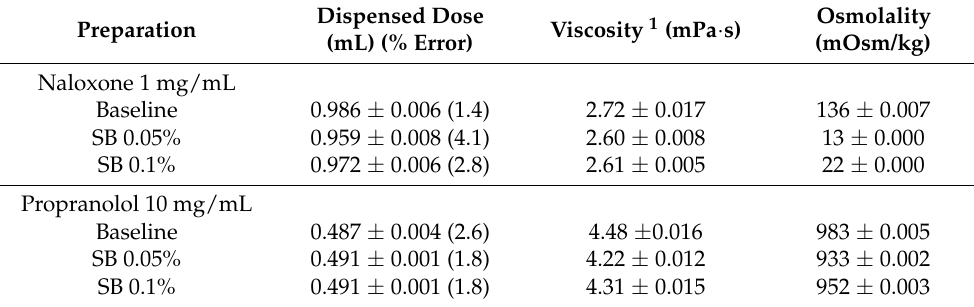
Table 8. Characterization of the selected (optimized) compositions regarding dispensed dose (dosing accuracy), viscosity and osmolality. Mean value ± 95% confidence interval of dispensed dose (% error) (n = 10), mean value ± coefficient of variation of viscosity and osmolality (n = 2). Naloxone dose = 1 mL (corresponding to 1 mg naloxone) and propranolol dose = 0.5 mL (corresponding to 5 mg propranolol). Acceptable dosing accuracy (i.e., error in dispensed dose) was set to ± 10% of target dose.